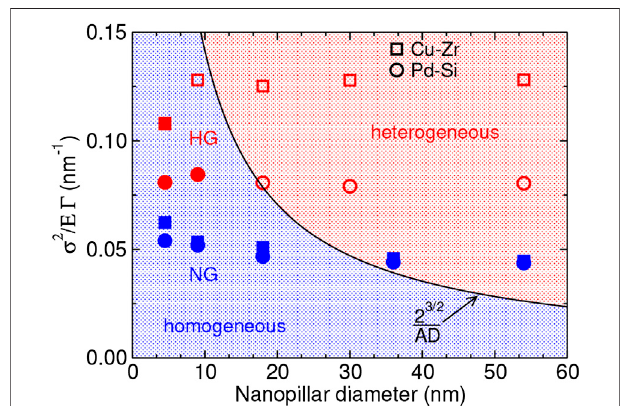
FIGURE 4 | Flow stress normalized by Young ’ s modulus and shear band energy per unit area as a function of the nanopillar diameter at 5% total strain. Red squares and red circles represent Cu 64 Zr 36 and Pd 80 Si 20 homogeneous glass (HG) nanopillars, respectively. Blue squares and blue circles represent Cu 64 Zr 36 and Pd 80 Si 20 nanoglass (NG) nanopillars, respectively. Open symbols indicate the occurrence of a shear band.